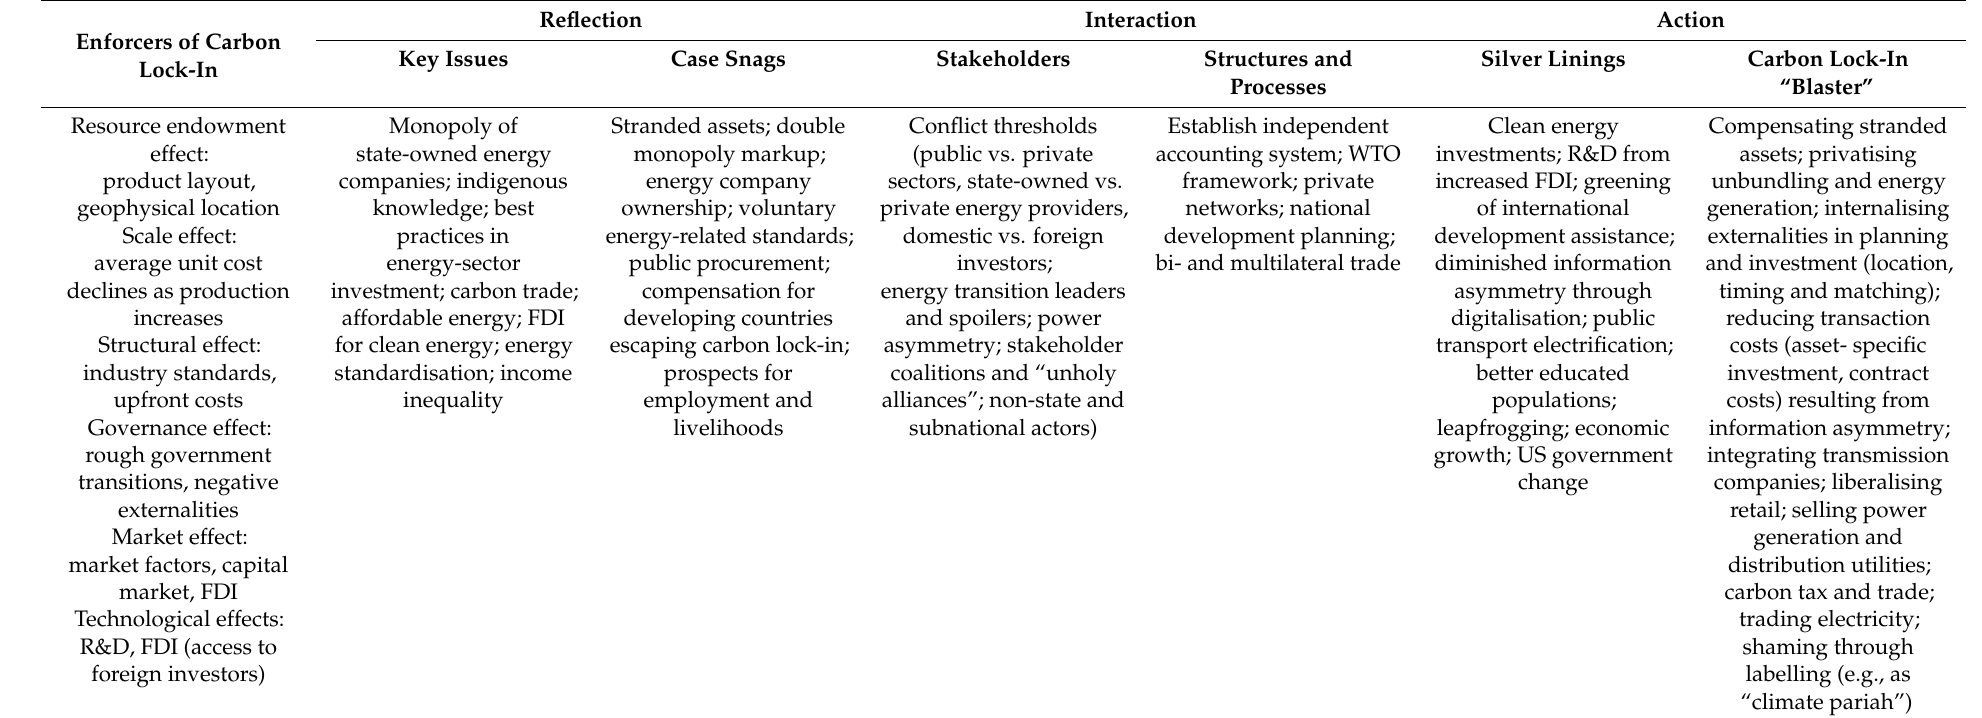
Table A1. Carbon lock-in in Mexico’s energy transition—The Learning Activation